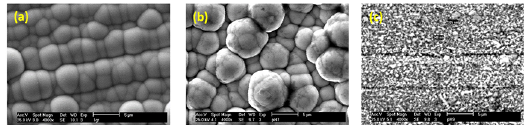
Figure 8. SEM micrographs of Ni-P coating and Ni-P-Cu composite coating with different pHs of the solution: a) pH=4.5, b) pH=7, c)